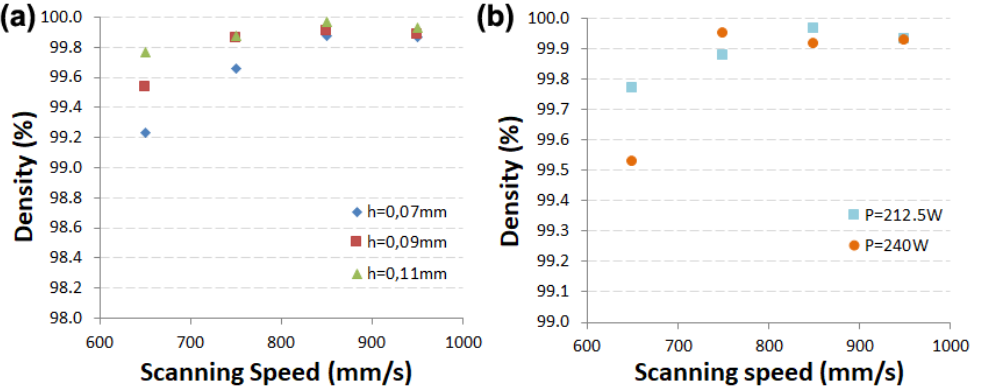
Figure 6. Evolution of material density as a function of scanning speeds for different hatch distance and laser power. ( a ) Material density for 212.5 W, and ( b ) density evolution using 0.11 mm hatch distance.